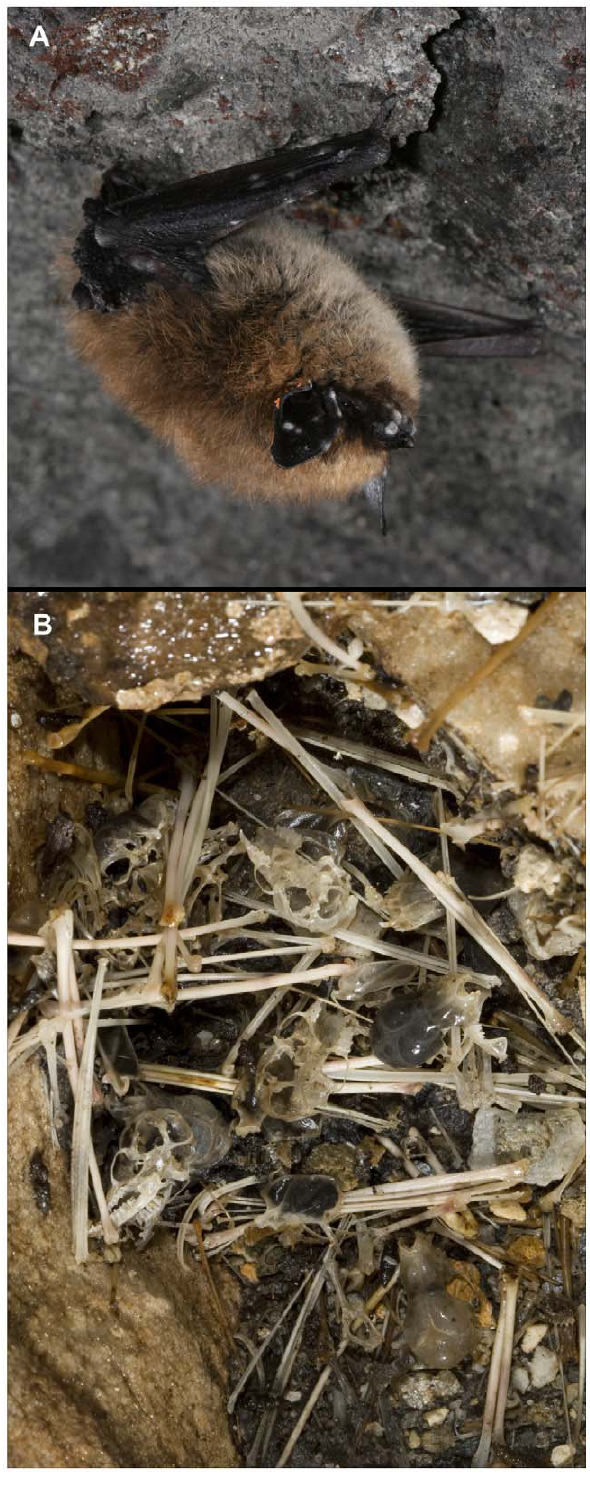
Figure 1. Images documenting clinical signs of white-nose syndrome (WNS) and devastating effects of the disease upon a wild bat population. (A) Eastern small-footed bat ( Myotis leibii ) with WNS photographed in April 2009, in Graphite Mine, New York, USA. Note characteristic white and gray fungal growth on the bat’s muzzle, ear, and wing. (B) Bat skeletal remains on the floor of Aeolus Cave, Vermont, USA, photographed in 2010, approximately two years after white-nose syndrome was first identified at this site. Photo credit: Alan